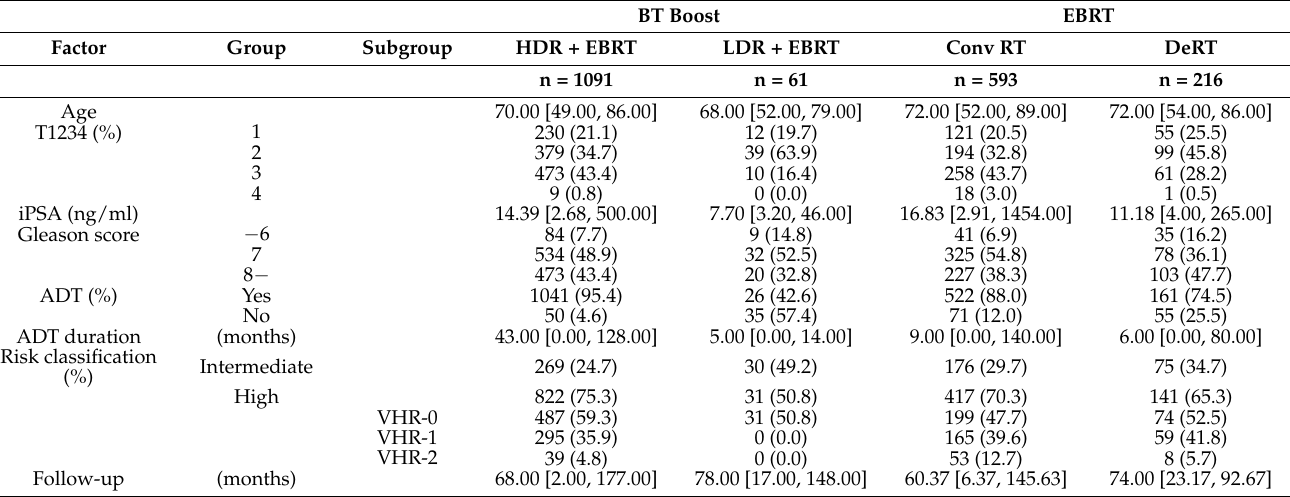
Table 2. Detailed patient characteristics among